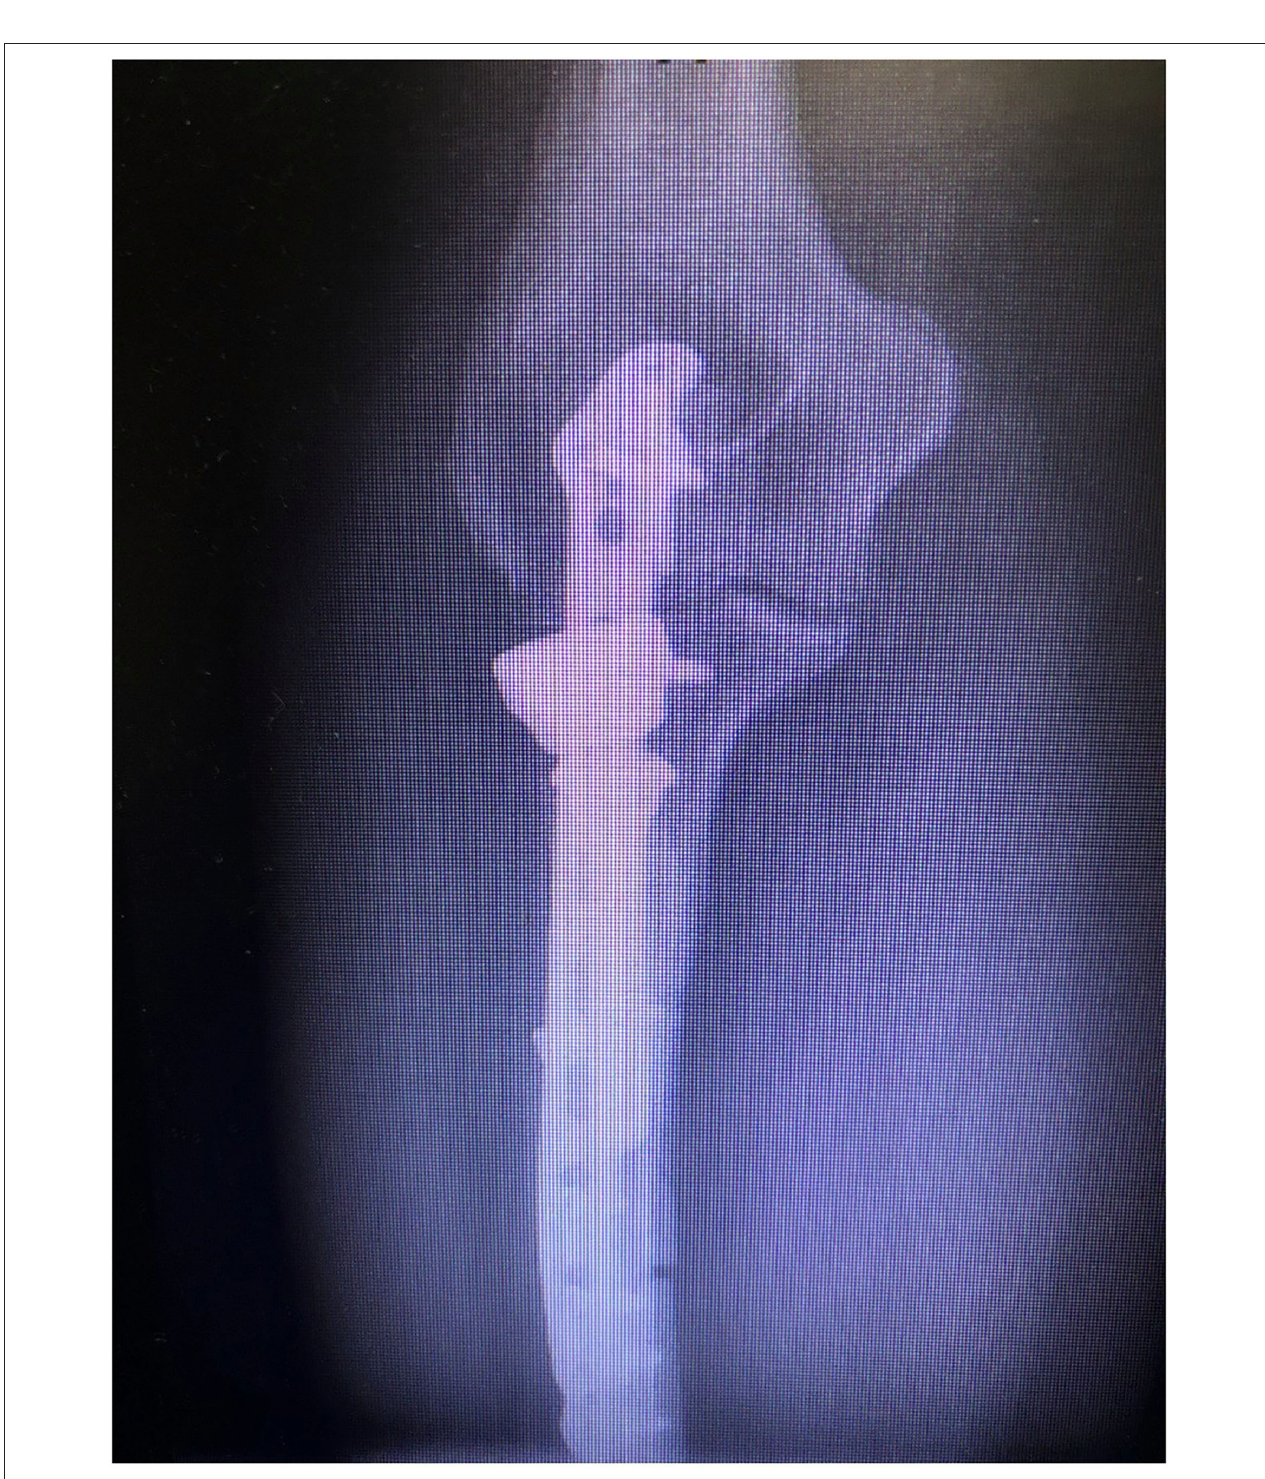
FIGURE 3 | Post-op AP view (osteosynthesis of the ulna with proximally contoured locking plate and radial head